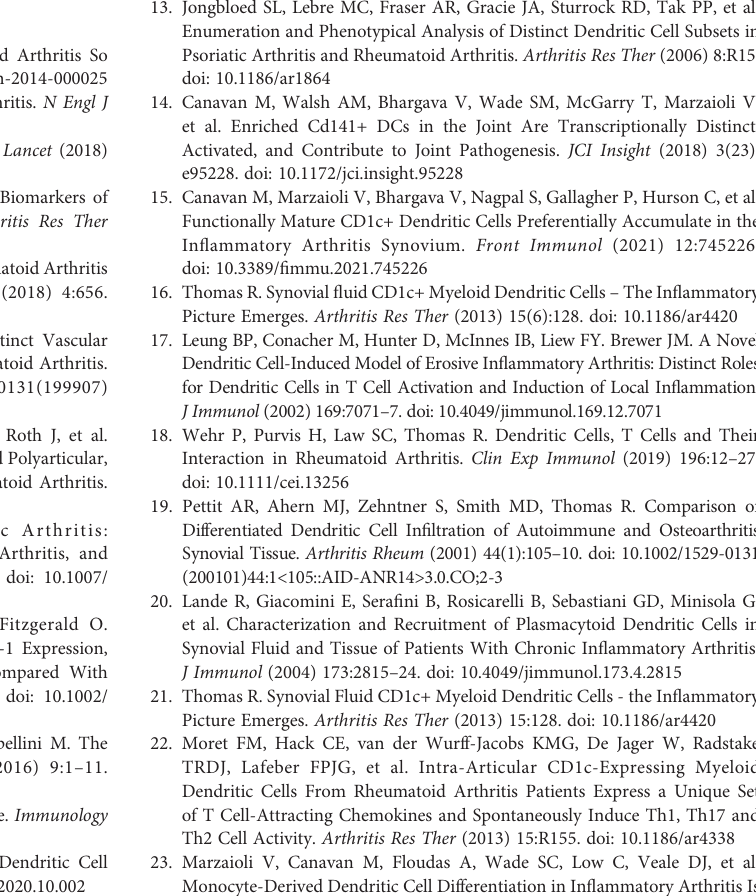
CD14 + )) of the chemokines receptors CCR6 (red arc), CCR7 (yellow arc), CXCR3 (green arc), CXCR4 (pink arc) and CXCR5 (blue arc) and corresponding (B) Pie Legend for all the combination of chemokine receptors. (C) Dot plot of negative population (cells not expressing chemokine receptors), CCR6 + CXCR3 + , CCR6 + CCR7 + CXCR3 + , CCR6 + , CCR7 + , CXCR4 + expressing cells. Data are represented as mean ± SEM Supplementary Figure 3 | Intracellular staining for GM-CSF, IL-2, IFN g and TNF a expressed in synovial CD4 + T cells alone orco-cultured withsynovial CD209 + DC. Left, representative fl ow plot. Right, Line graphs for n=2. Supplementary Figure 4 | (A) Representative fl ow plot of lineage negative cells from HC left untreated (Basal n=4), treated with 20% OA synovial fl uid (SF n=7), or with GMCSF/IL4 (n=4) cocktail. (B) Histogram representing the frequency of CD209/CD14 + DC and frequency of the maturation markers CD40, CD80, CD83, singularly expressed. Differences among groups were evaluated by non-parametric t-test (Mann-Whitney test) *p<0.05. (C) Flow analysis of isolated CD209+ DC from HC left untreated (n=4) or stimulated with 20% SF from OA (n=6), displaying the frequency of the chemokine receptors CCR6, CCR7 and CXCR3. Data are represented as mean ± SEM. Supplementary Figure 5 | (A) Multiplex analysis of RA SF (n=16), PsA SF (n=15) and OA SF (n=11) analytes included chemokines (I-TAC, IP-10, MDC, SDF-1 a , MCP-1, MCP-2, MCP-3, MCP-4, MIP-1 a , MIP-1 b , MIP-3 a , MIP-3 b ) and cytokines (GM-CSF, IL-12p70, IL-1 b , IL-33, IL-4, TNF a , TNF b ) and). (B) Differentially expressed chemokines and cytokines in RA vs PsA fl uid. Data are represented as mean ± SEM and differences among groups were evaluated by non-parametric t- test (Mann-Whitney test) *p <